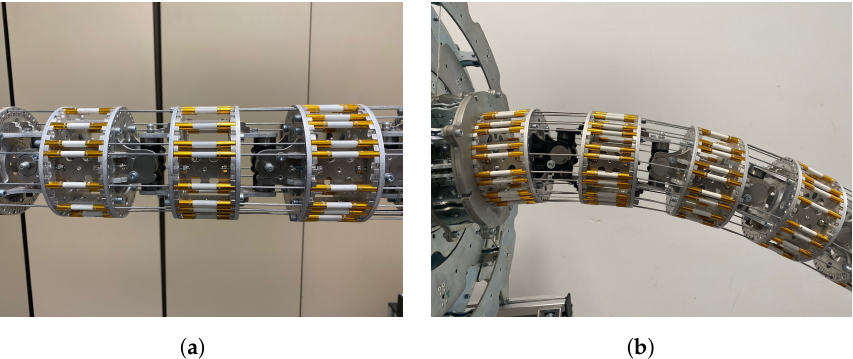
Figure 23. Details of MACH-I that suggest the discreet CDHR classification. ( a ) Detail of joints and straight cables between sections. ( b ) Detail of sections and cables with curved robot.